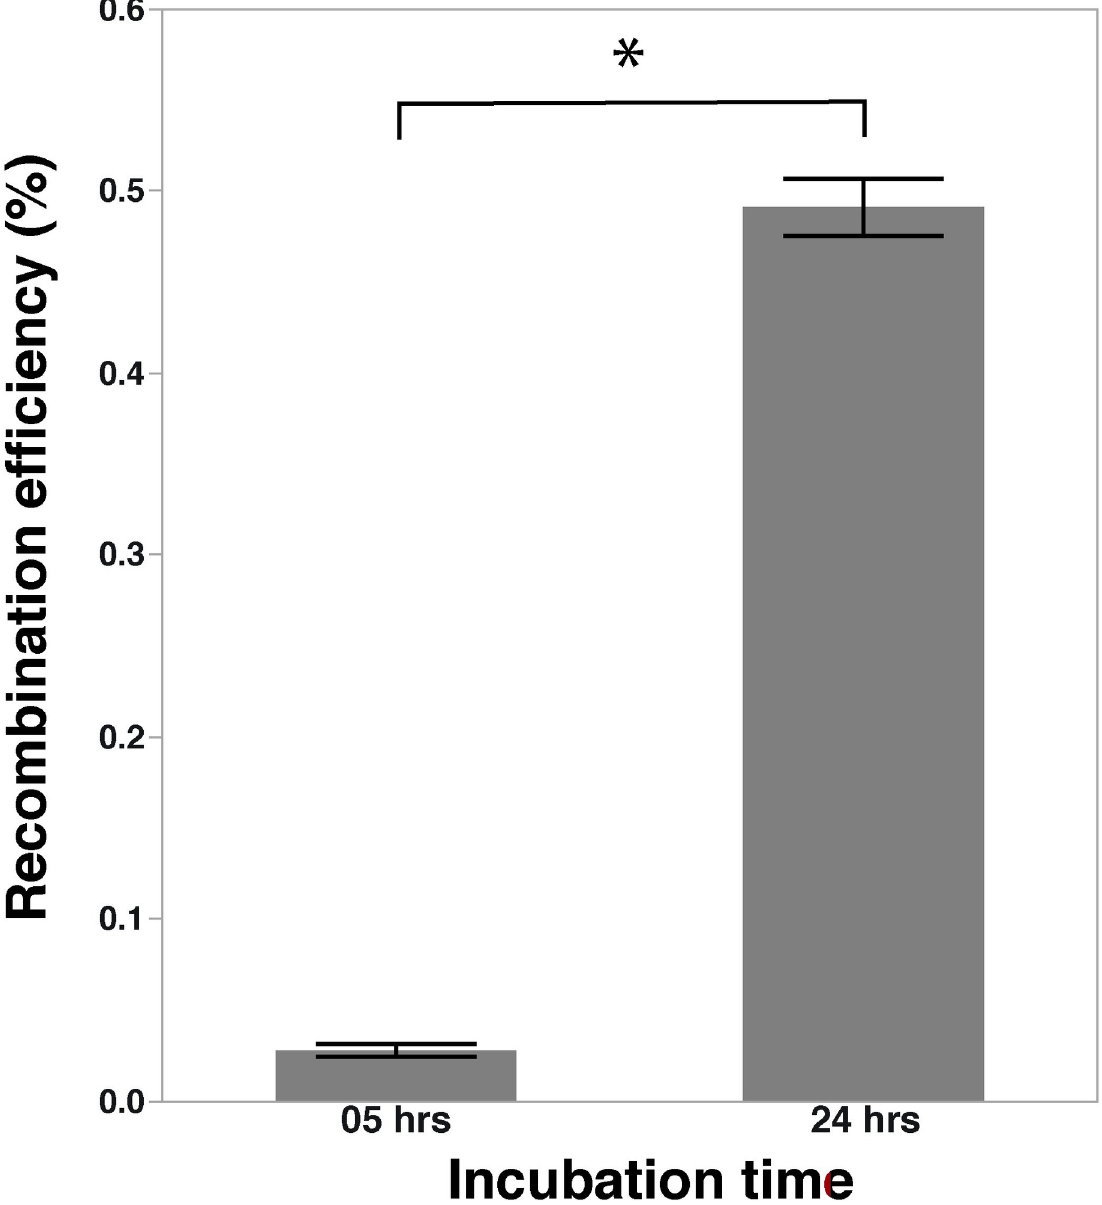
Fig 5. Comparison of the recombinant levels between incubation for 5 hrs (control) vs. 24 hrs. Recombinant levels expressed as percentage recombinants in the total number of parent cells; � indicates a significant difference at P < 0.05. was compared to that of the control recombination assay where both marker strain cells were used. In the recombination experiment where Cm R (cells) + Km R (cell-free) was used, the number of recovered recombinant cells was significantly lower than the control (0.01024 ± 0.000987% vs. 0.03294 ± 0.0014% of parent strain cells). In recombination experiment where Cm R (cell-free) + Km R (cells) was used, the recombination efficiency reduced more dramati- cally (0.00002122 ± 0.00001% of the parent strains) (Fig 8). The recombination efficiency with the control recombination assay was 0.0329 ± 0.001405% of the parent strains. This indicates that the absence of cells in the supernatant affects the DNA uptake, which in turn reduced the